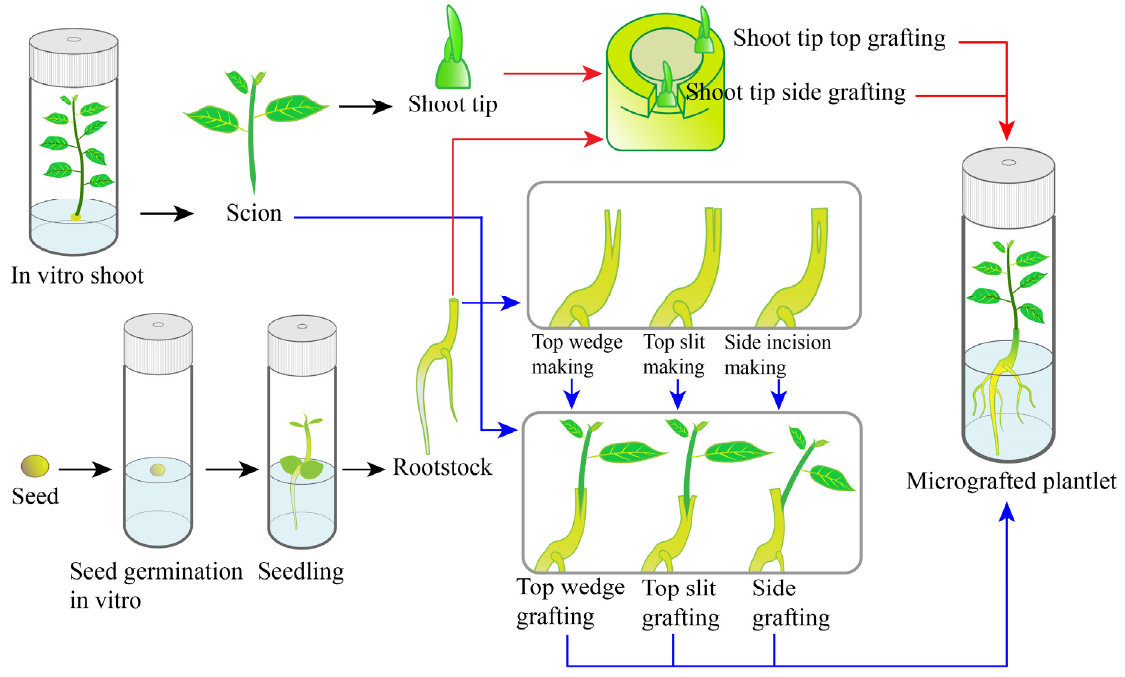
Figure 1. Schematic illustrations of in vitro micrografting methods. An in vitro-germinated seedling decapitated at the epicotyl is demonstrated as the rootstock. Black arrows indicate the preparation of scion and rootstock before the grafting process. Red arrows indicate the micrografting of shoot tips onto the rootstock using the top grafting and side grafting methods. Blue arrows indicate the use of in vitro shoots as scions in micrografting, and the top-wedge grafting, the top-slit grafting and the side grafting are